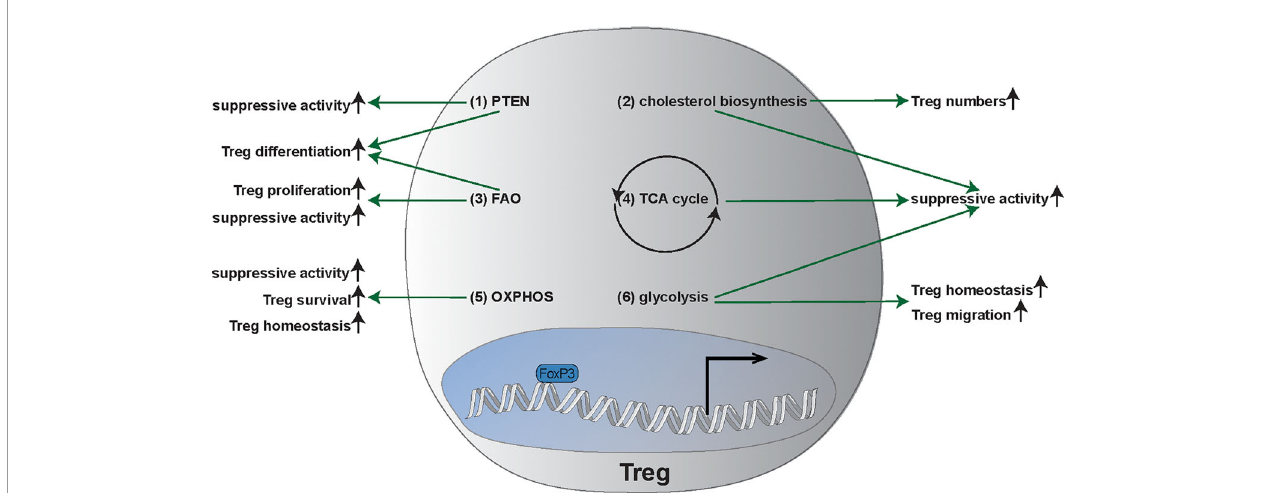
FIGURE 3 | Main metabolic pathways and metabolic plasticity of Tregs. (1) Phosphatase and tensin homolog (PTEN) enhances regulatory T cell (Treg) differentiation as well as the suppressive activity of Tregs. (2) Cholesterol biosynthesis is required for suppressive functionality of Tregs and increases Treg frequency. (3) Fatty axid oxidation (FAO) is important for Treg generation, proliferation, as well as the suppressive activity. (4) Tricarboxylic acid cycle (TCA): TCA promotes the suppressive activity of Tregs. (5) Oxidative Phosphorylation (OXPHOS) is not only important for survival of Tregs but also for the suppressive capacity as well as the homeostasis of Tregs. (6) Glycolysis promotes suppressive function, the migration, and the homeostasis of Tregs. FAO, fatty acid oxidation; OXPHOS, oxidative phosphorylation; PTEN, Phosphatase and tensin homolog; TCA, Tricarboxylic acid cycle; Tregs, regulatory T